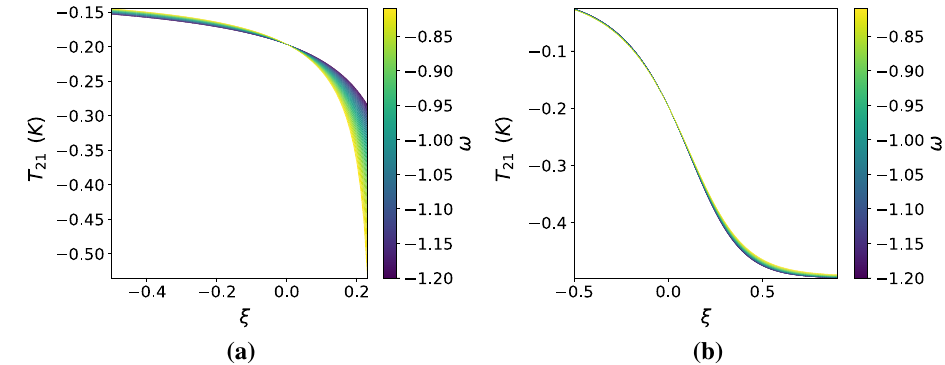
Fig. 2 21-cm brightness temperature as a function of the interaction parameter and the equation of state at z = 20. a Model proportional to the energy density of DE, Q = 3 H ξ 2 ρ d . b Model proportional to the energy density of DM, Q = 3 H ξ 1 ρ